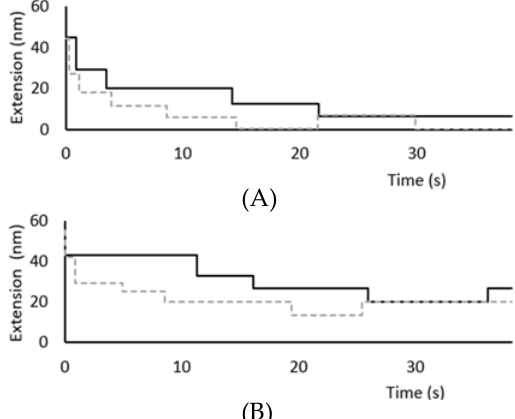
Figure 5 . Refolding Traces of (I83) 6 polymer at 4 pN and 10 pN. Sample unfolding traces at ( A ) 4 pN and ( B ) 10 pN of force illustrate faster and more dynamic refolding in presence of calcium (dashed gray) vs. the absence of calcium (black) as demonstrated by a greater decrease in extension and more frequent folding transitions over time.